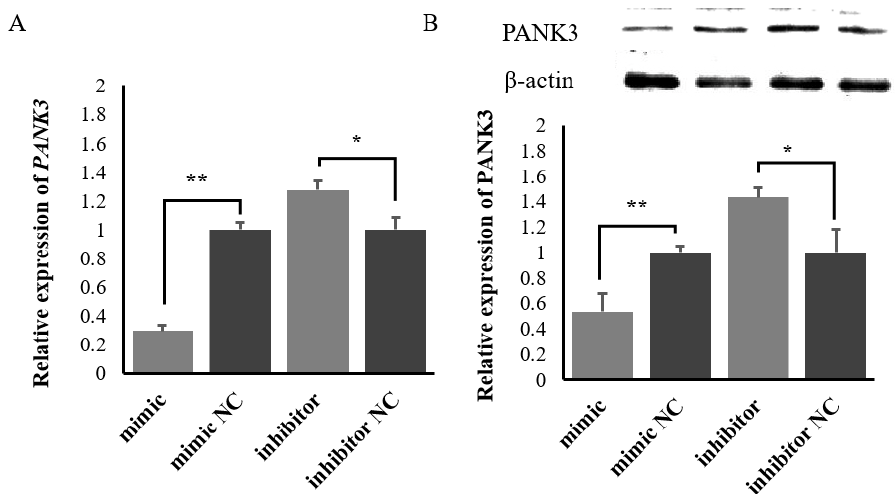
Figure 5. The expression of PANK3 at the mRNA and protein levels when the miR-200c mimic or the miR-200c inhibitor were transfected into ovine mammary epithelial cells (MECs). ( A ) The regulation of the mRNA level of PANK3 by miR-200c. ( B ) The regulation of the protein level of PANK3 by miR-200c. Data are presented as mean ± SD for three replicates; ** p < 0.01 and * p < 0.05. The name of each strip from left to right was mimic, mimic NC, inhibitor and inhibitor NC.